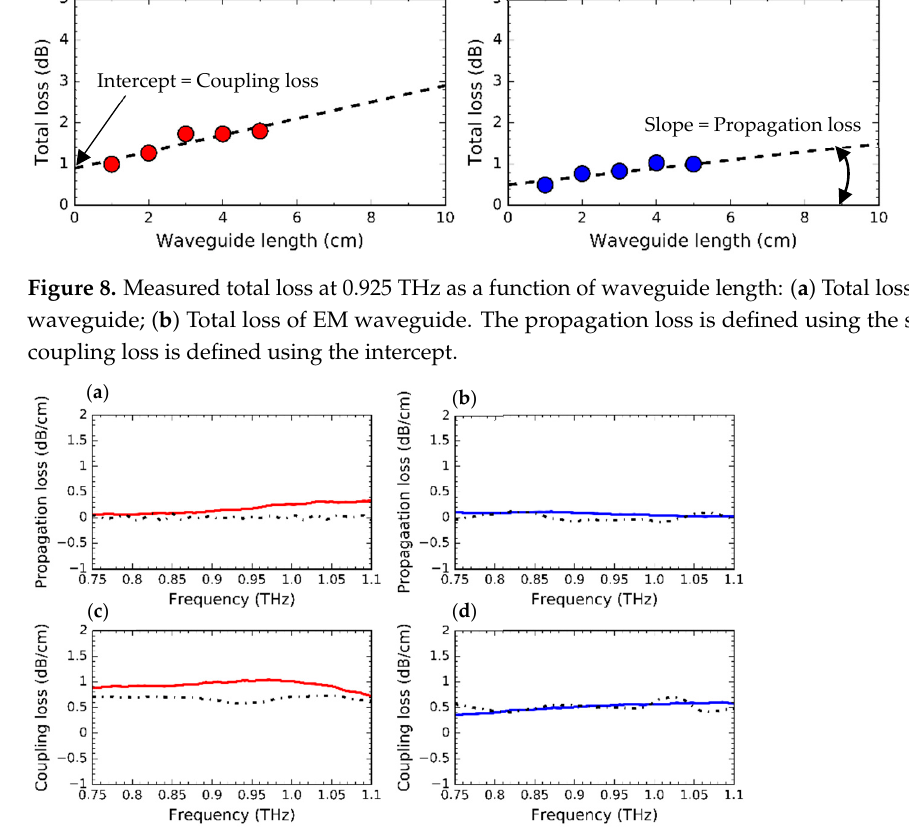
Figure 9. Measured (solid) and simulated (dashed) propagation loss and coupling loss: ( a ) Propagation loss of unclad waveguides; ( b ) Propagation loss of EM waveguide; ( c ) Coupling loss of unclad waveguide; ( d ) Coupling loss of EM waveguide.